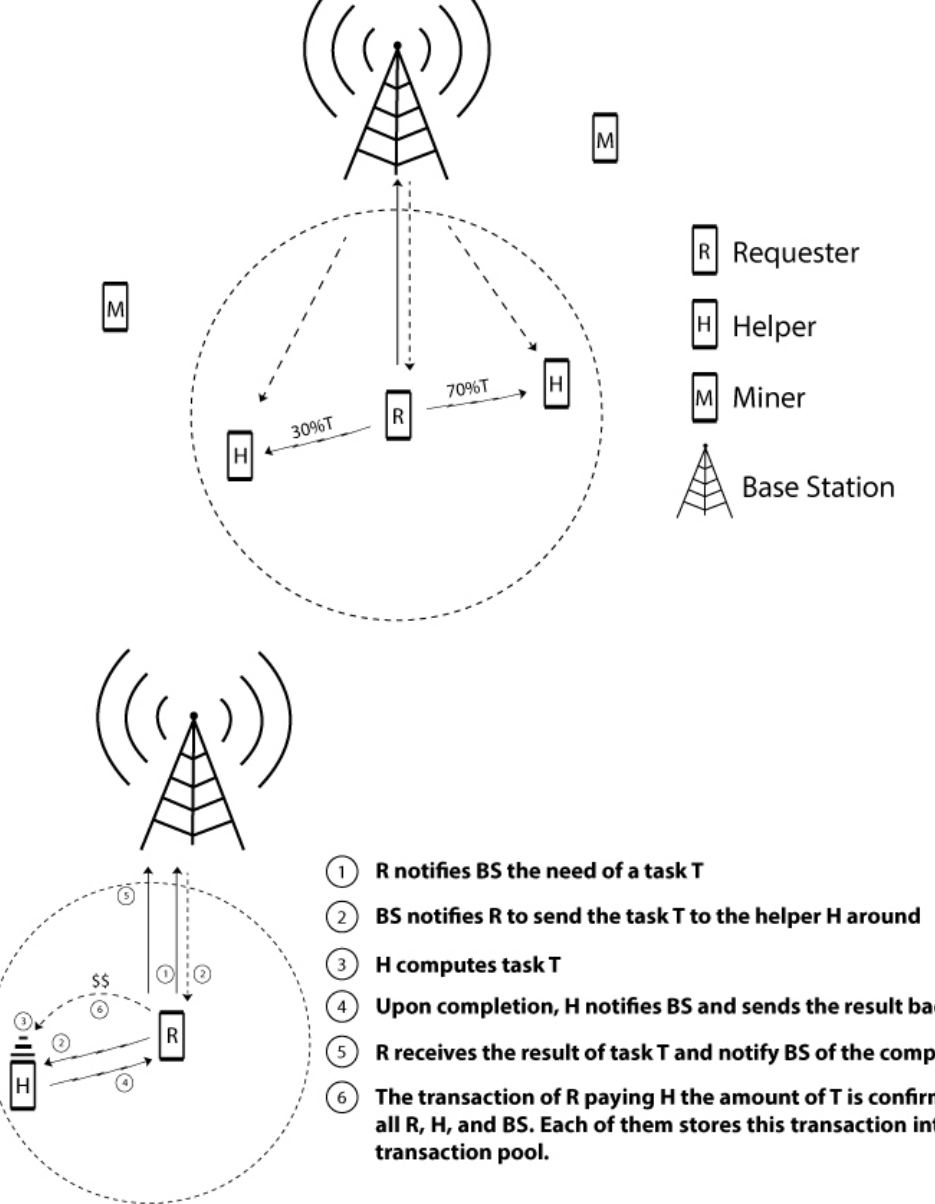
Figure 2. Task scheduling in the D2D